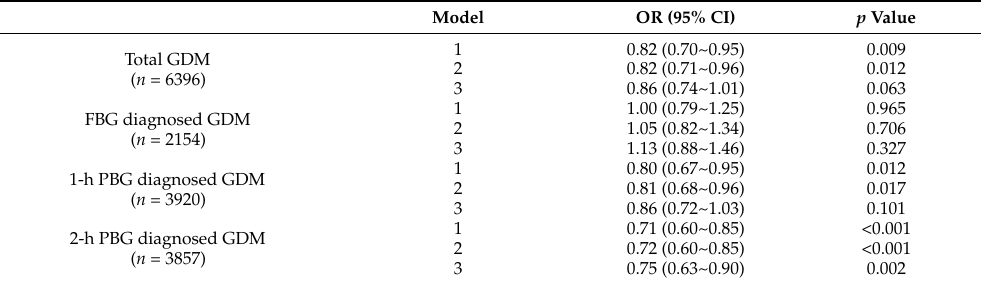
Table 2. ORs and 95% CI of GDM risk associated with early pregnancy folic acid supplementation.